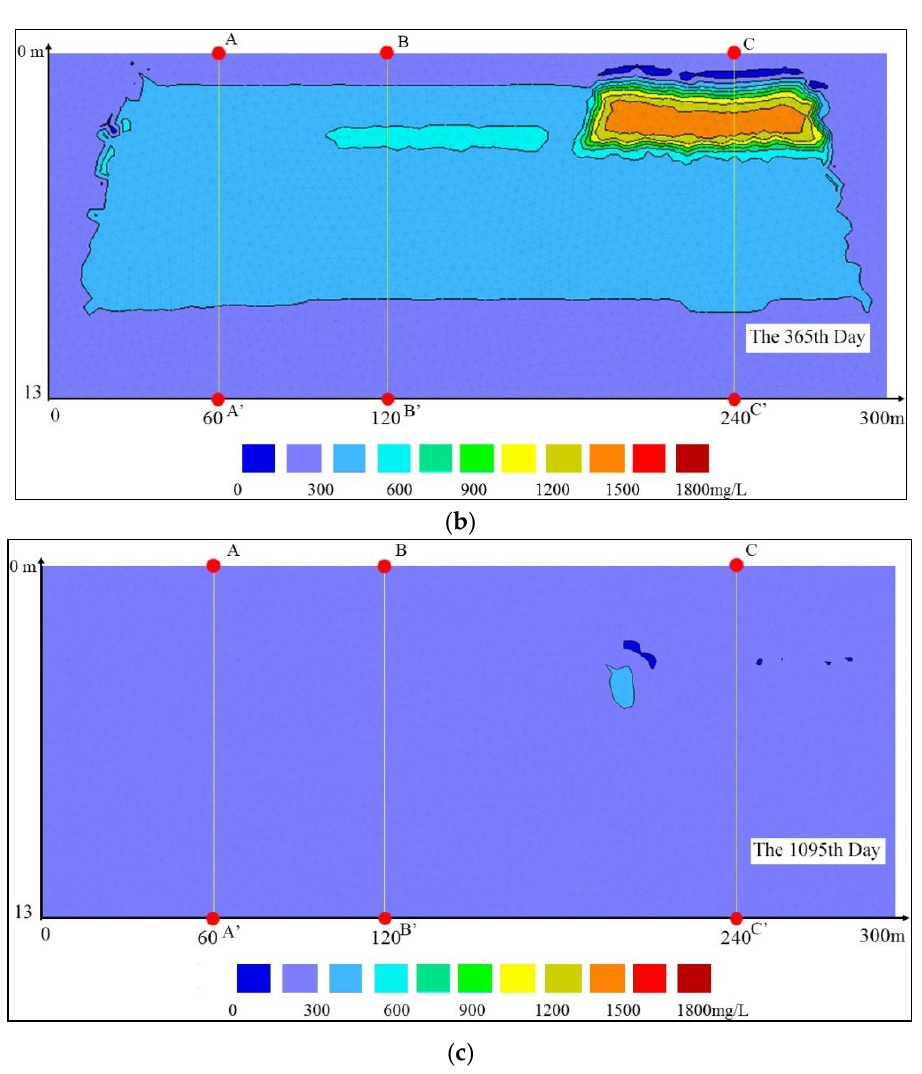
Figure 4. NH 4+ distribution after ( a ) 270 days; ( b ) 365 days; and ( c ) 1095 days.